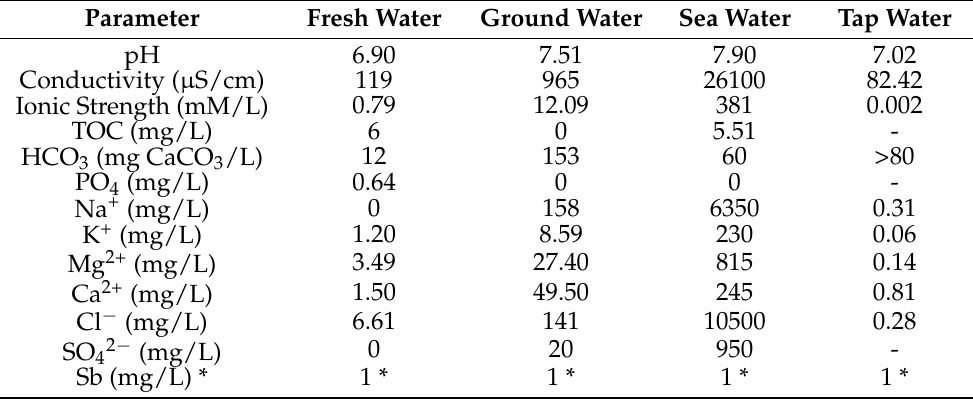
Table 3. Characteristics of synthetic and natural water